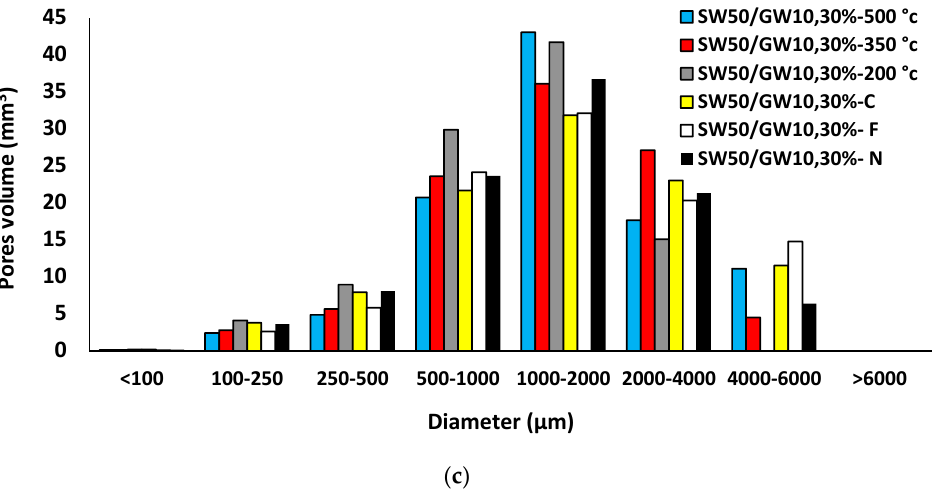
Figure 17. Porous structure characteristics of SW50/GW10-2% Fiber-30% Foam after exposure to different testing conditions: ( a ) total porosity; ( b ) numbers of pores; ( c ) pore volume.